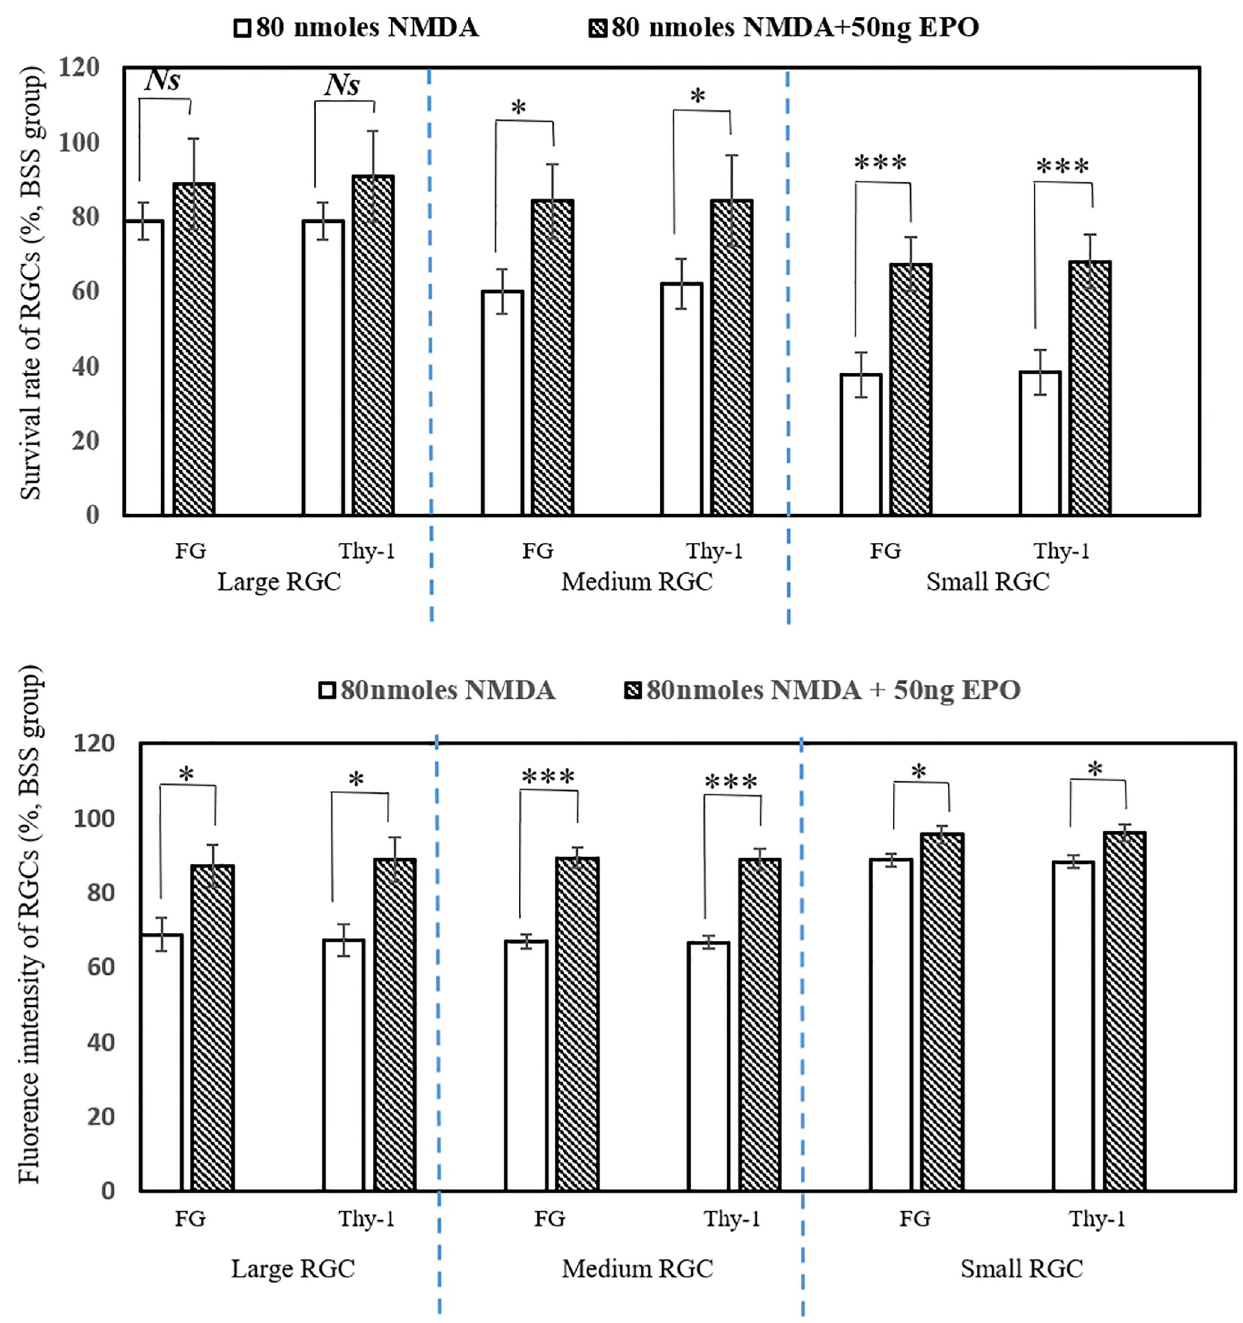
Fig 2. The survival rate and cell health of RGCs were mediated with EPO by flow cytometry (BSS only as 100%): The survival rate of small & medium RGCs were significantly recovered by the treatment of EPO, compared with 80 nmoles NMDA-mediated groups ( � p < 0.05; �� p < 0.01; ��� p < 0.001) (n = 6) (Upper). EPO-mediated the cell health of all RGCs were evaluated by the intensity of fluorescence (%FG and %Thy-1 intensity) and significantly recovered by the treatment of EPO, compared with 80 nmoles NMDA-mediated groups: ( � p < 0.05; �� p < 0.01; ��� p < 0.001) (n = 6)